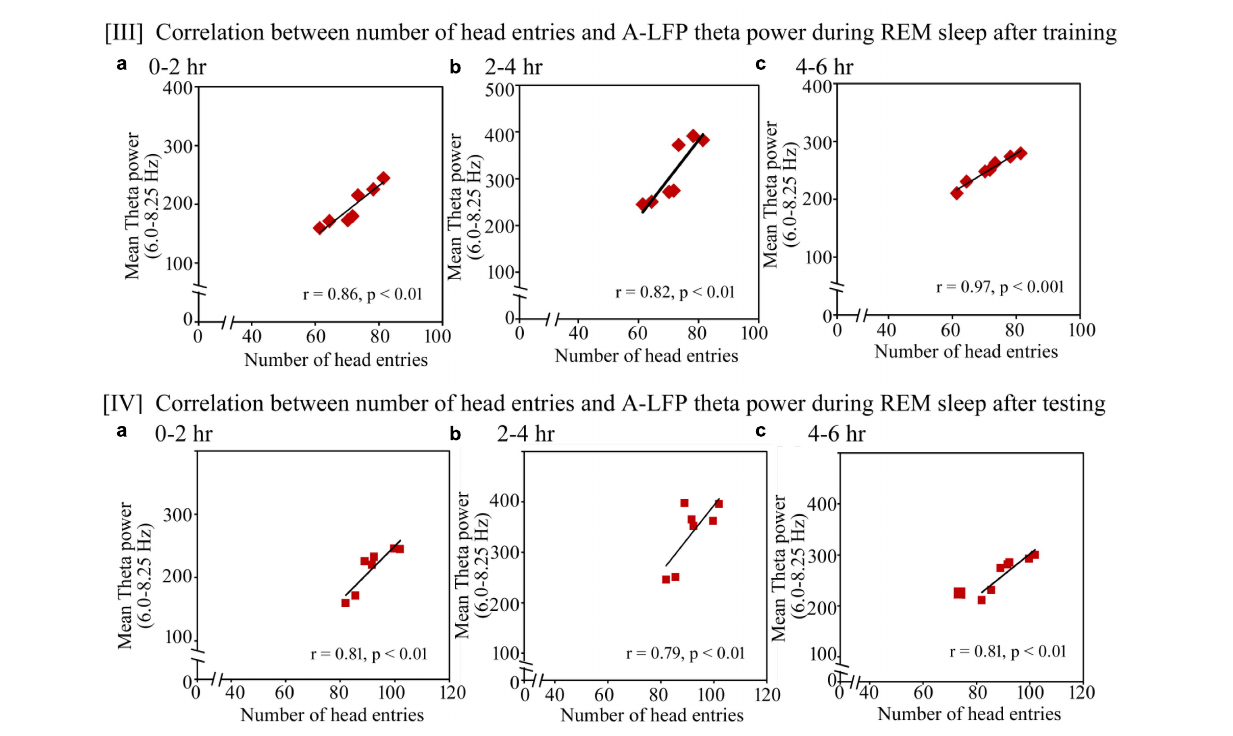
FIGURE 9 | Pearson correlation between performance and percent change in A-LFP oscillatory waves during NREM and REM sleep during the training and testing day. (I) On the appetitive-conditioned training day, the number of head entries significantly positively correlated with the increased power of SWA (a) in the range of 0.1–1.5 Hz ( r = 0.89; p < 0.01) at 0–2 h, (b) in the range of 0.1–3 Hz at 2–4 h ( r = 0.85; p < 0.01), and (c) in the range of 0.1–3 Hz at 4–6 h ( r = 0.95; p < 0.001). (II) The number of head entries also positively significantly correlated with the increased power of SWA in the range of (a) 0.1–3.75 Hz ( r = 0.81; p < 0.01) at 0–2 h; (b) 0.1–3 Hz ( r = 0.79; p < 0.01) at 2–4 h; and (c) 0.1–3 Hz ( r = 0.86; p < 0.01) at 4–6 h during NREM sleep on the testing day. (III) The increased theta power (6–8.25 Hz) during REM sleep also significantly positively correlated with performance during (a) 0–2 h ( r = 0.86; p < 0.01), (b) 2–4 h ( r = 0.82; p < 0.01), and (c) 4–6 h ( r = 0.97; p < 0.001). (IV) The increased theta power (6–8.25 Hz) during REM sleep also significantly positively correlated with performance during (a) 0–2 h ( r = 0.81; p < 0.01), (b) 2–4 h ( r = 0.79; p < 0.01), and (c) 4–6 h ( r = 0.81; p < 0.01). A-LFP, amygdalar local filed